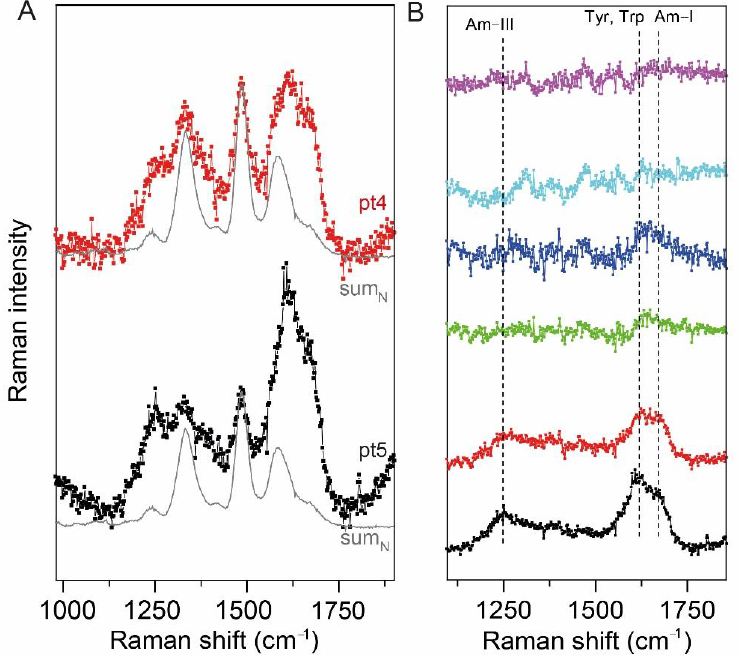
Figure 3. ( A ) UVRR spectra of patients 4 and 5 (depicted in red and black lines + symbol) superimposed by sum N (depicted in gray). In this case, the experimental UVRR spectra are not properly matched by the sum N spectrum. ( B ) the difference UVRR spectra obtained by subtracting the pure spectrum of RNA from the ones collected, in order to enhance the contribution of biological contaminants (i.e., proteins) to the final UVRR spectra.